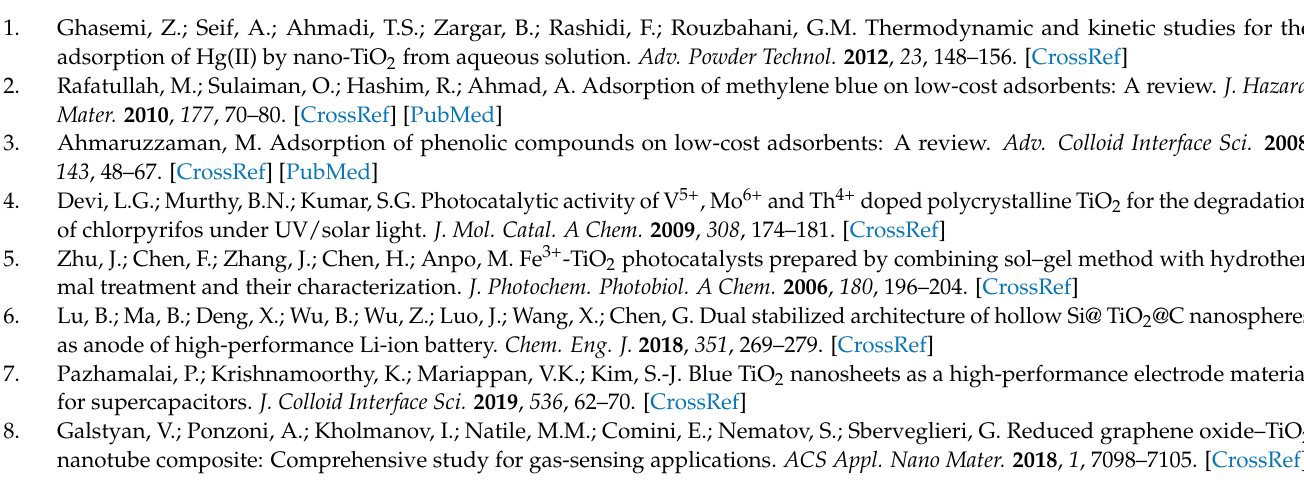
Mo-2.2; Figure S5: High-resolution XPS spectra of Mo 3d region in studied samples; Figure S6: XPS deconvolution of Mo 3d core level in (a) TiO 2 -Mo-0.9, (b) TiO 2 -Mo-1.5, and (c) TiO 2 -Mo-2.2; Figure S7: High-resolution XPS spectra of O 1s region in investigated samples; Figure S8: XPS deconvolution of O 1s core level in (a) TiO 2 , (b) TiO 2 -Mo-0.9, (c) TiO 2 -Mo-1.5, and (d) TiO 2 -Mo-2.2; Figure S9: Raman spectrum of TiO 2 -Mo-3.9; Figure S10: Effect of contact time on the adsorption of Rh.B. for TiO 2 -Mo-3.1 compared to commercial adsorbents ( C o = 10 mg L − 1 , temperature =